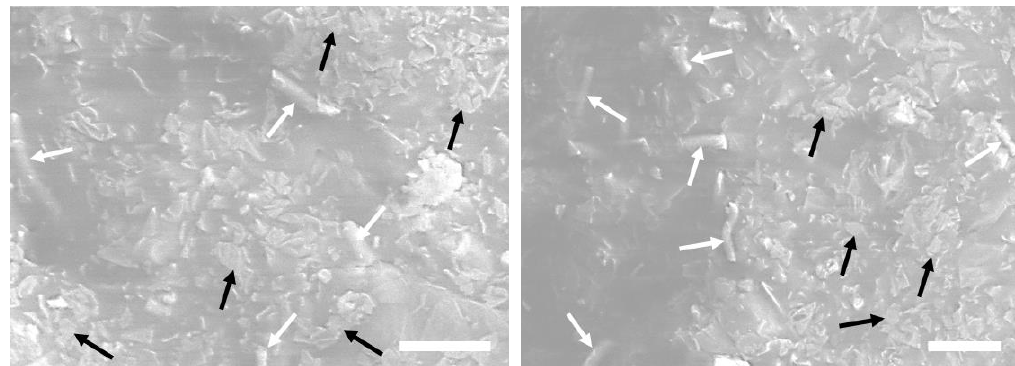
Figure 6. TEM images of the ( a , b ) SBR/GO and ( c , d ) SBR/rGO – SH.